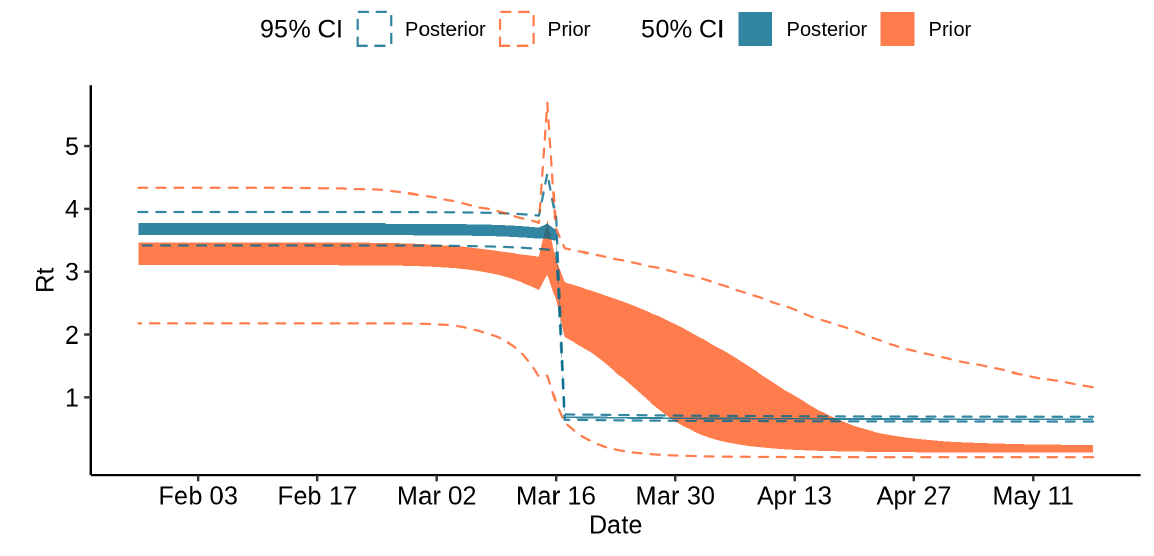
Figure 9 – Prior and posterior samples of R t in region Île-de-France